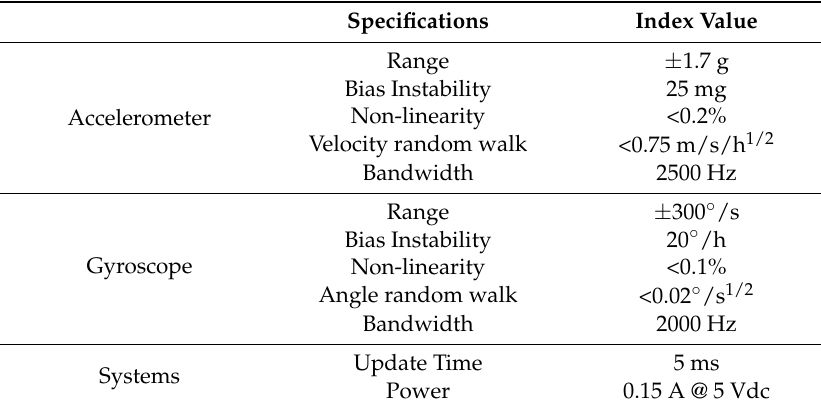
Table 1. Main technical indicators of the MEMS IMU.